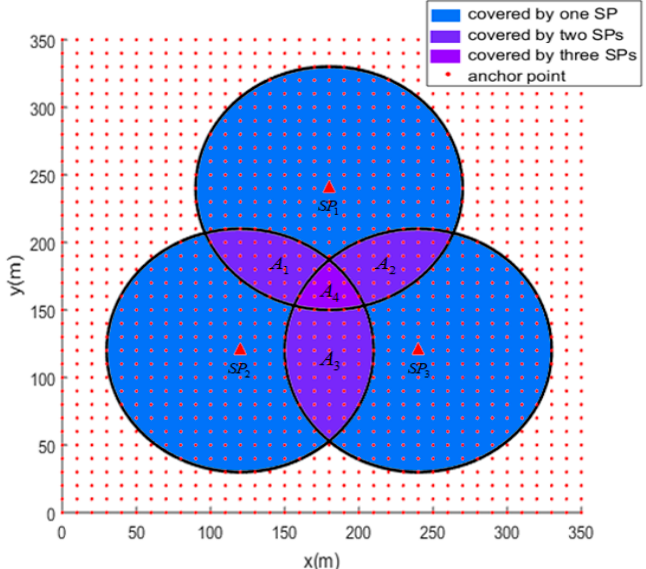
Figure 6. Anchors for coverage rate calculation.